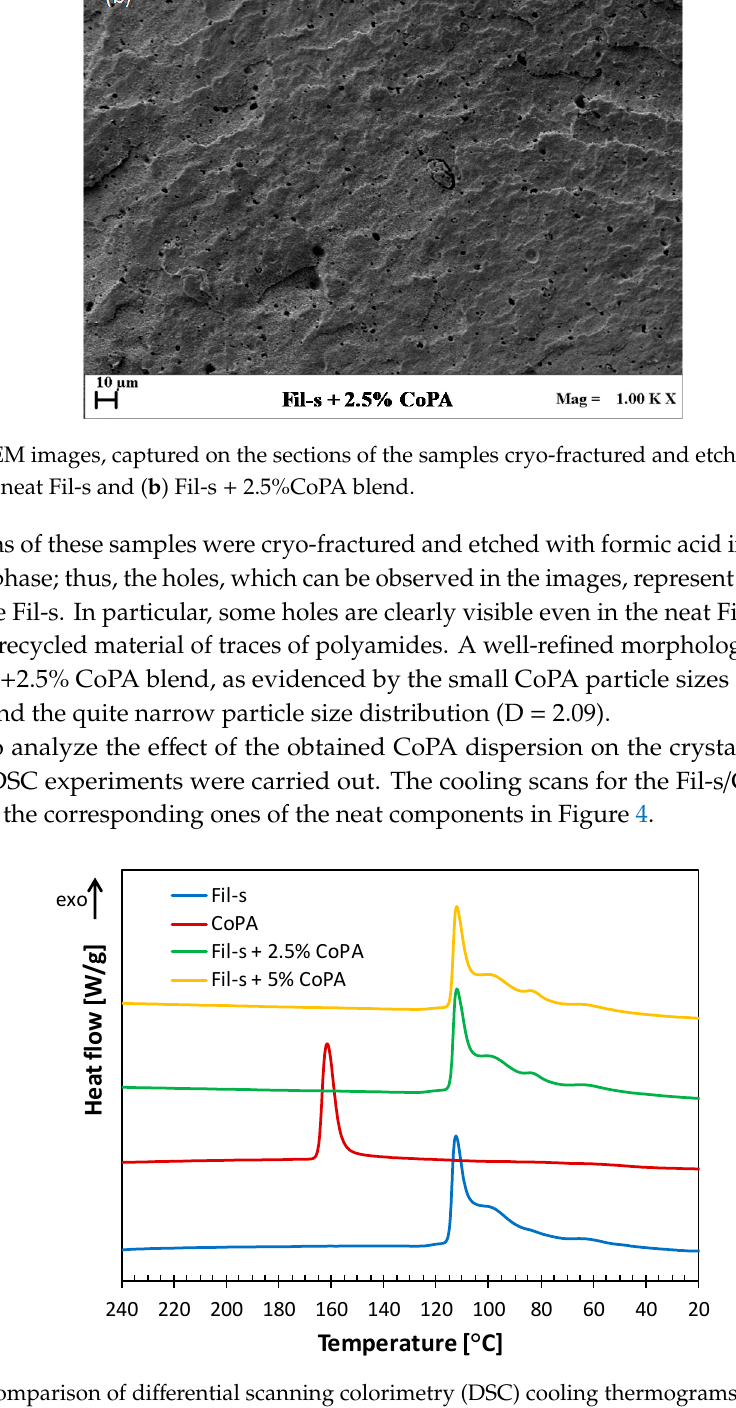
Figure 4. Comparison of differential scanning colorimetry (DSC) cooling thermograms of Fil-s, CoPA, and their blends.